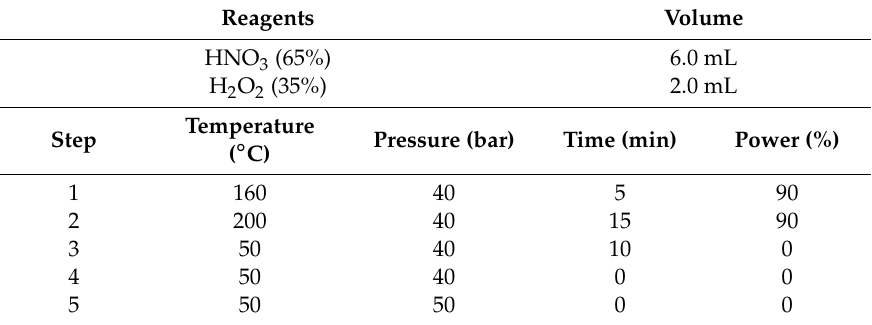
Table 7. Optimized program for the microwave digestion parameters for oil of the babassu.